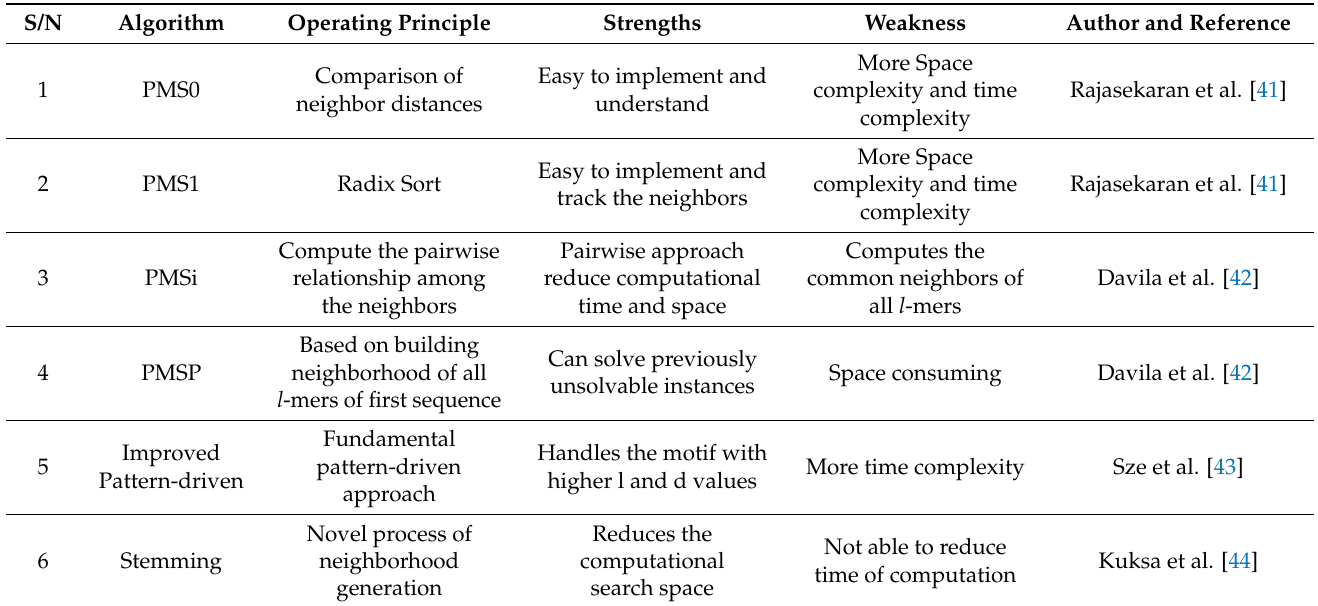
Table A4. List of Exact Motif Discovery Algorithms based Enumeration of